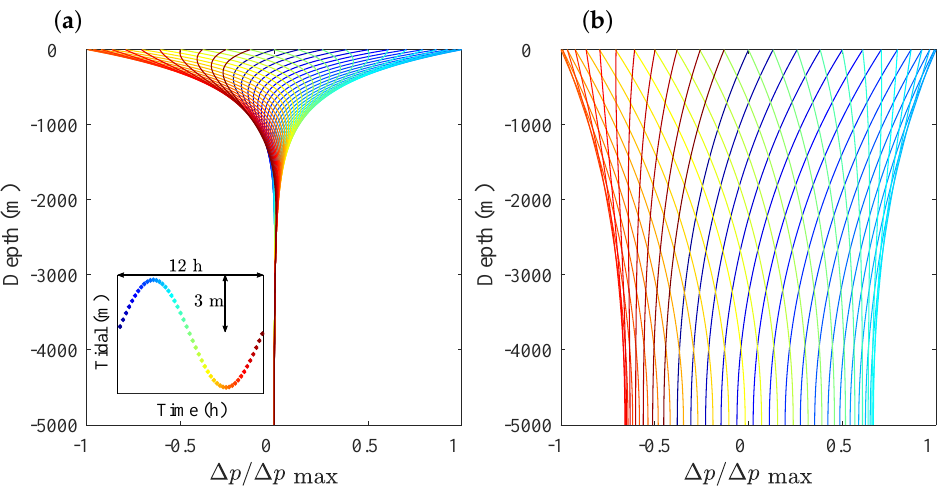
Figure 3. Plot of the evolution of pore pressure increment along the fault zone during a single tidal cycle. We perform 2D models with the Darcy law. We plot the pore pressure changes up to 5 km deep for a 3 m amplitude and 12 h tidal cycle. We consider two values of the fault permeability, k F , (( a ), k F = 10 − 11 m 2 , and ( b ), k F = 10 − 9 m 2 ). Pore pressure changes are referred to the maximum value of the surface pore pressure, which corresponds to the high tide situation. We represent the pore pressure increment for several time instants during the tidal cycle. The colors vary from cold (early times) to warm (late times) as the simulation time advances. The color map and range used in panel ( b ) inset is the same for both panels. The parameters of the simulations related to this Figure are listed in Table 1. The compressibility of the solid grains, χ s , is 2.33 · 10 − 10 Pa − 1 . The permeability of the fault